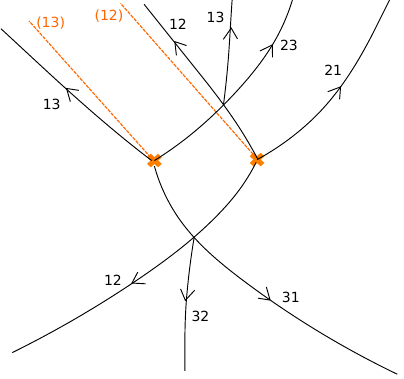
Figure 1 . A representative local picture of a Stokes graph in the neighborhood of two simple branch points of different types. The orange crosses represent simple branch points, while the orange dashed lines represent the choice of branch